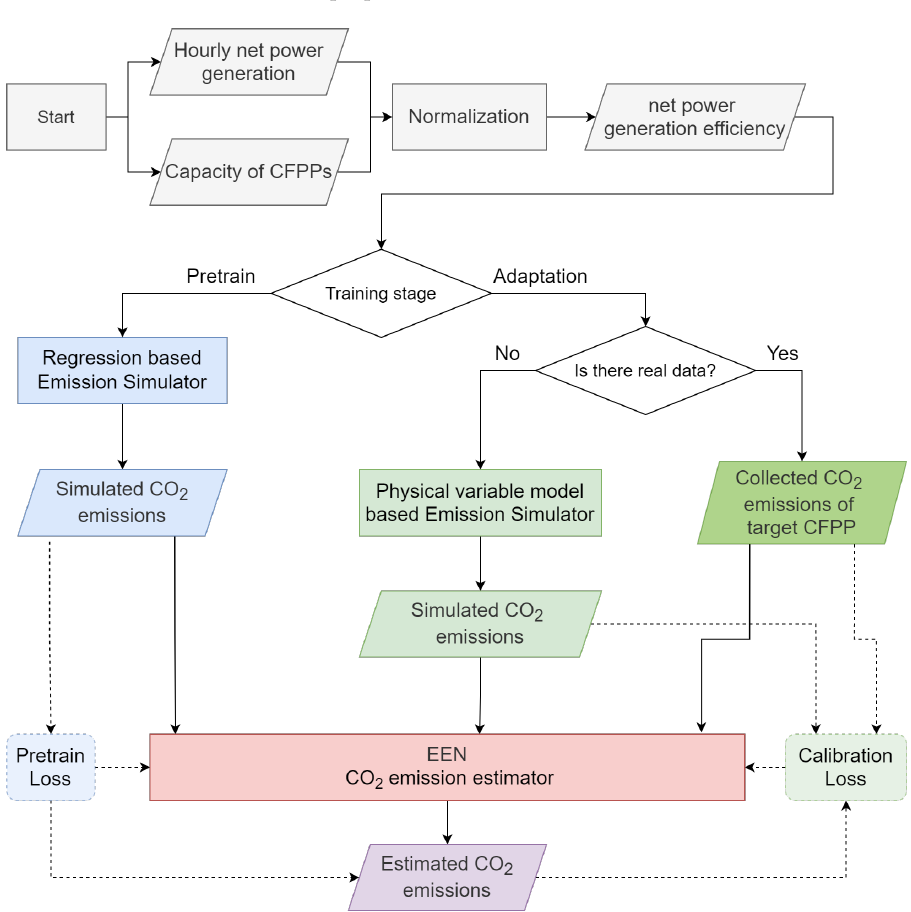
Figure 10. Flowchart of this